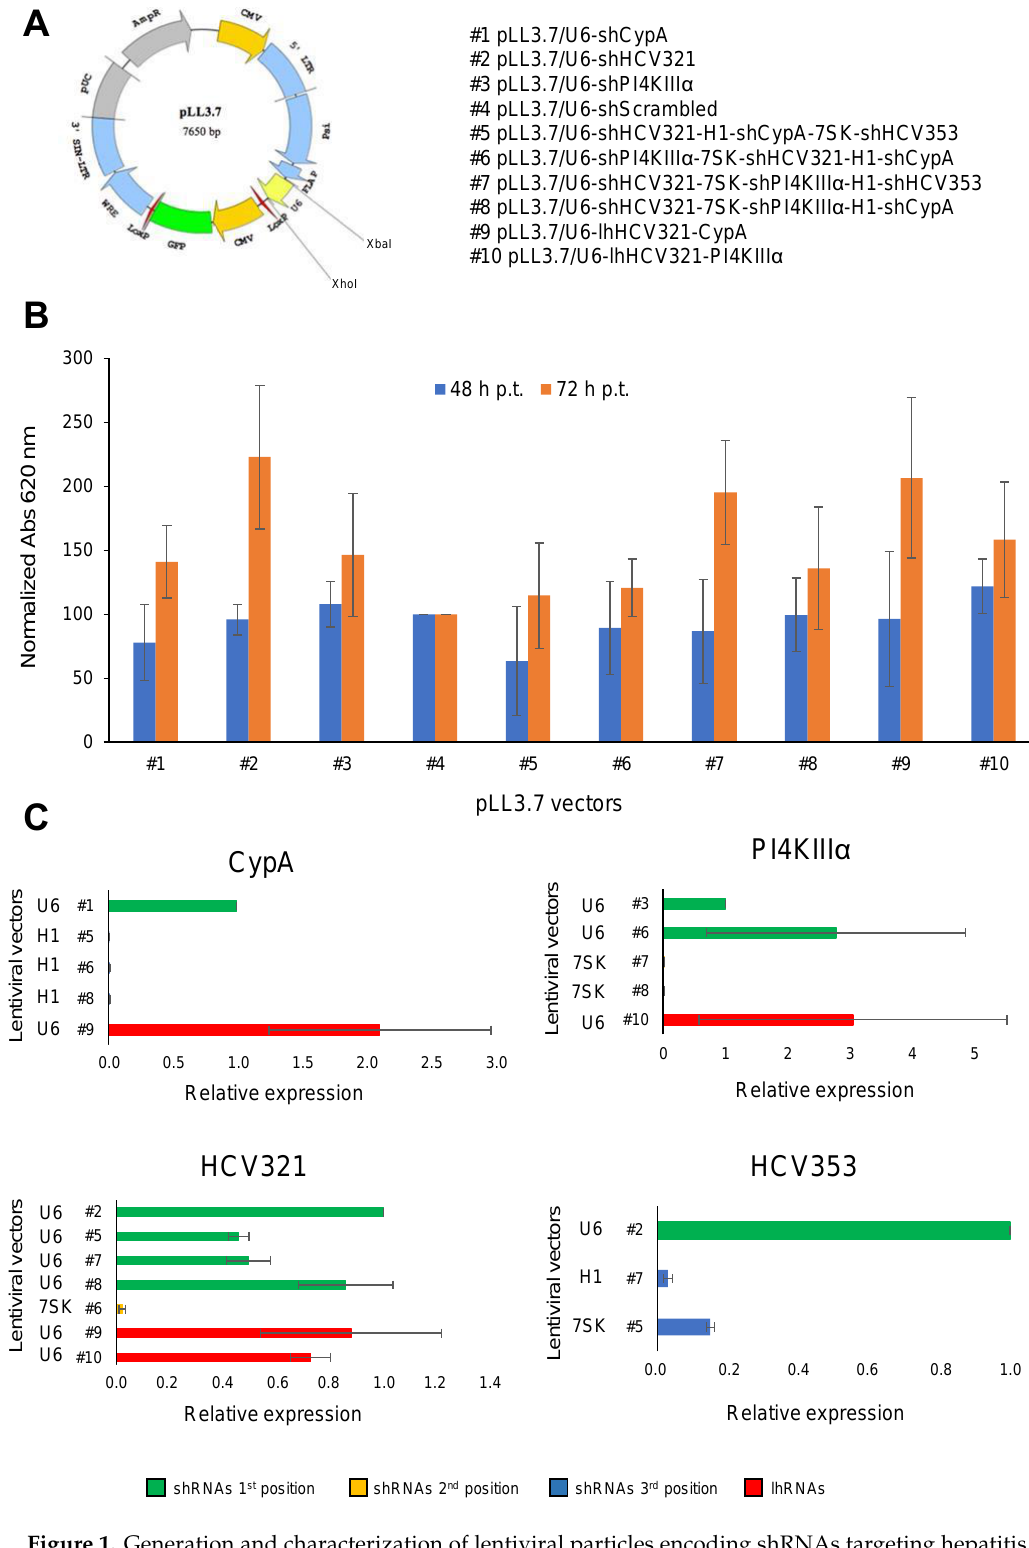
Figure 1. Generation and characterization of lentiviral particles encoding shRNAs targeting hepatitis C virus (HCV) replication. ( A ) Schematic representation of the different lentiviral vectors generated. The shRNA cassettes were inserted between the XbaI and XhoI sites of lentiviral vector pLL3.7 under the control of pol-III promoters. The name of the different vectors is reported on the right panel. ( B )